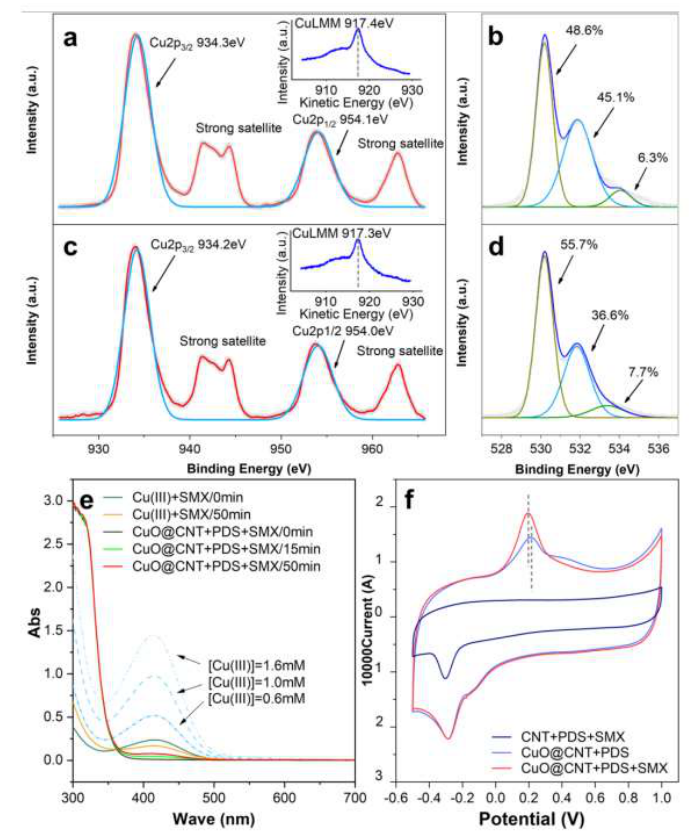
Figure 5. XPS of ( a ) Cu2p of fresh CuO@CNT, ( b ) O1s of fresh CuO@CNT, ( c ) Cu2p of used CuO@CNT, ( d ) O1s of used CuO@CNT, ( e ) UV–vis spectrum of Cu( Ⅲ ), ( f ) cyclic voltammograms (CVs) on CNTs and CuO@CNT electrode in 0.5 M Na2SO4 and 1.0 mM PDS; scan rate = 50 mVs −1 . Conditions: PDS = 1.0 mM, CuO@CNT = 0.1 g/L, SMX = 39.5 µM, Cu( Ⅲ ) = 0.4 mM, ( e ) pH = 13.0 ± 0.1, ( f ) pH = 5.6 ± 0.1.